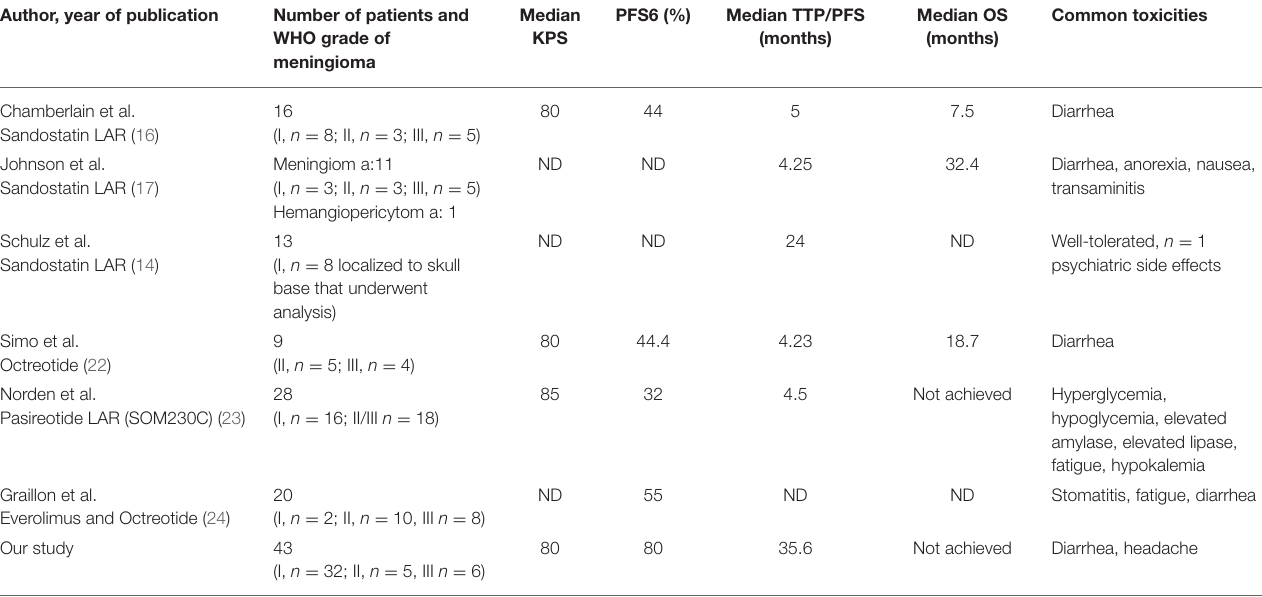
TABLE 5 | Studies of octreotide analogs in refractory recurrent